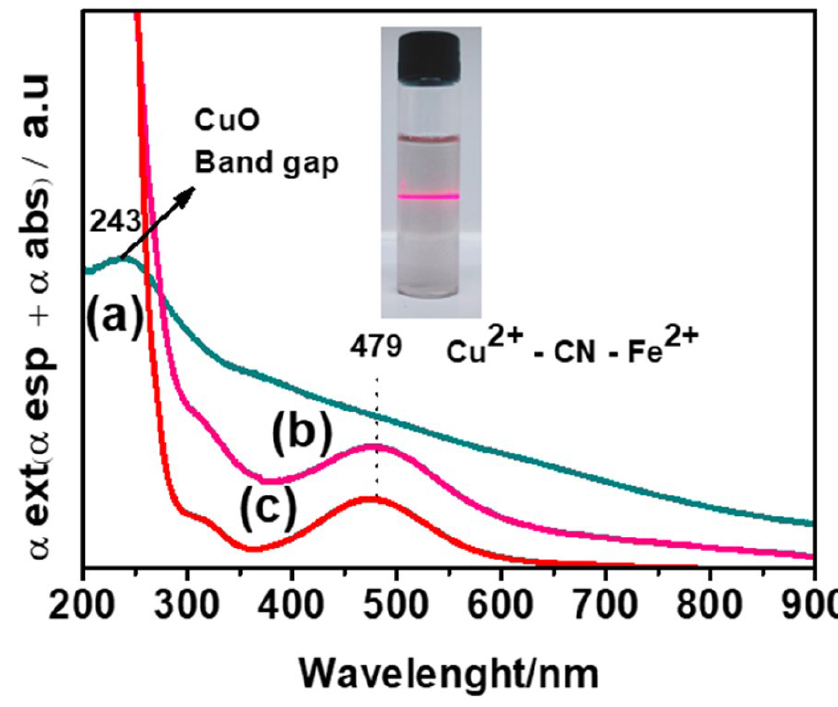
Figure 1. UV-Vis electronic spectra for aqueous dispersions: (a) CuO (0.3 mg mL -1 ); (b) Cu [Fe(CN) ] (0.1 mg 2 6 mL -1 ) and (c) CuO/Cu [Fe(CN) ] 2 6 (0.1 mg mL -1 ). Inset: Tyndall effect observed for the